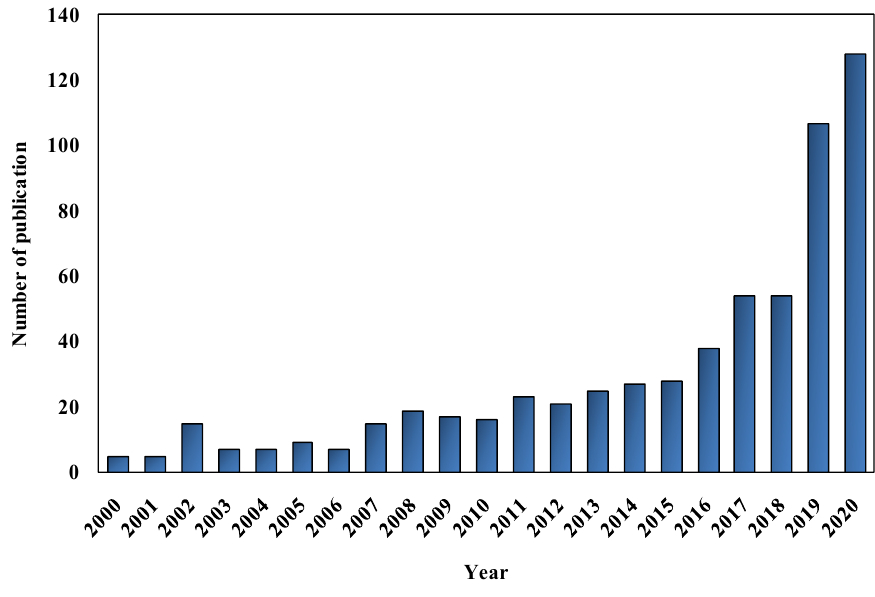
Figure 2. The Trend of Annual Publications on Zeolite Applications in Agriculture for the Last Two Decades. Source: Scopus Preview [37].